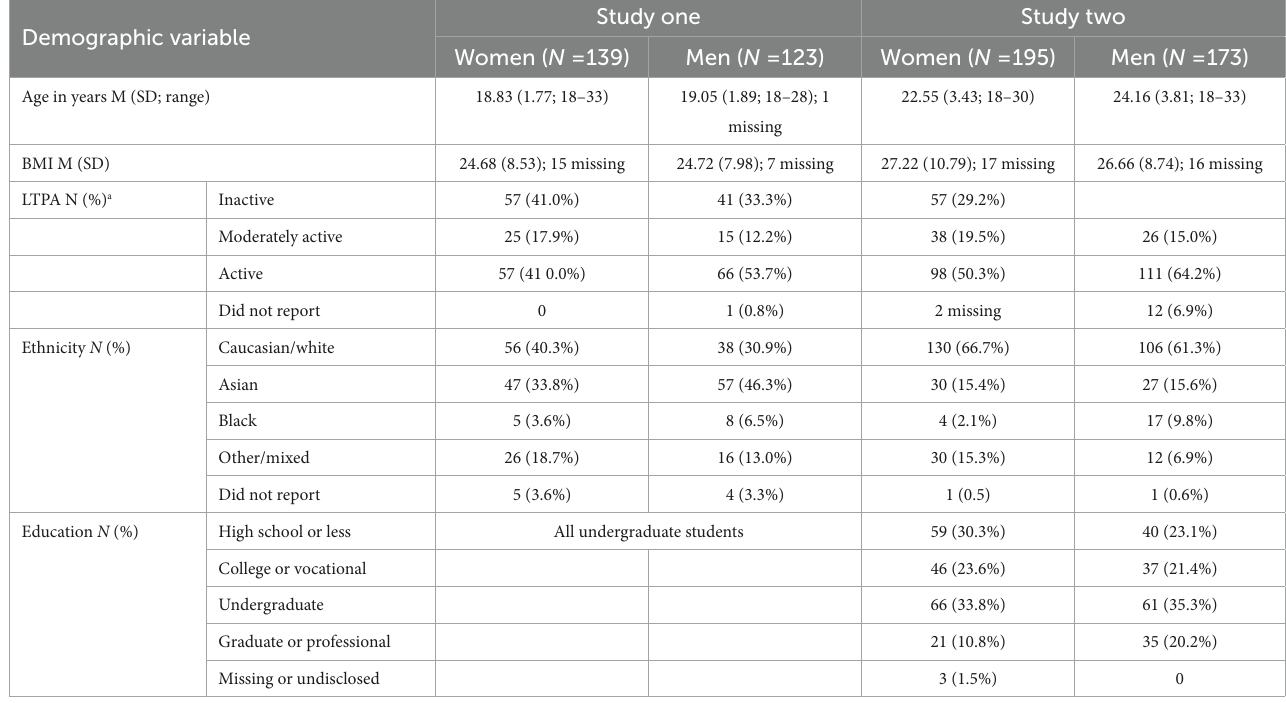
TABLE 1 Demographic information.